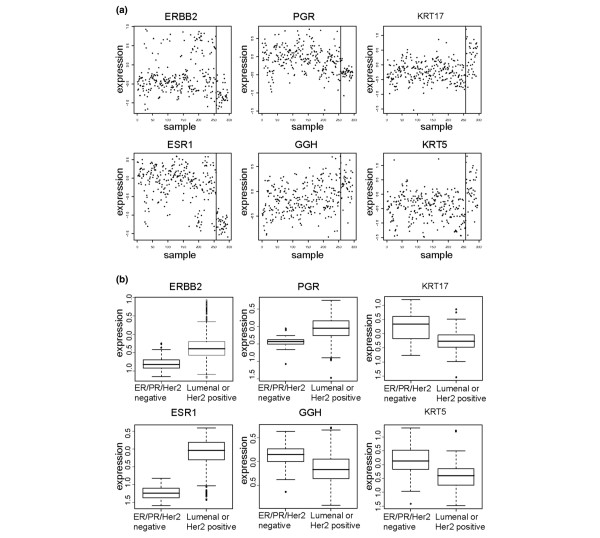
Expression of selected subtype specific markers in the breast cancer dataset [8]. (a) The y-axis shows the expression level of the gene, while the x-axis identifies each sample, ordered as in Figure 8. The vertical line shows the separation between sample clusters found in Figure 8. The right-most cluster shows decreased expression of estrogen receptor (ESR), HER2, and progesterone receptor (PGR) in most samples, and increased expression of keratin (KRT) 5 and gamma-glutamyl hydrolase (GGH). These markers are indicative of a mixture of basal-like and normal-like tumor subtypes. (b) Box plots showing the distributions of expression for subtype markers in the two observed clusters.